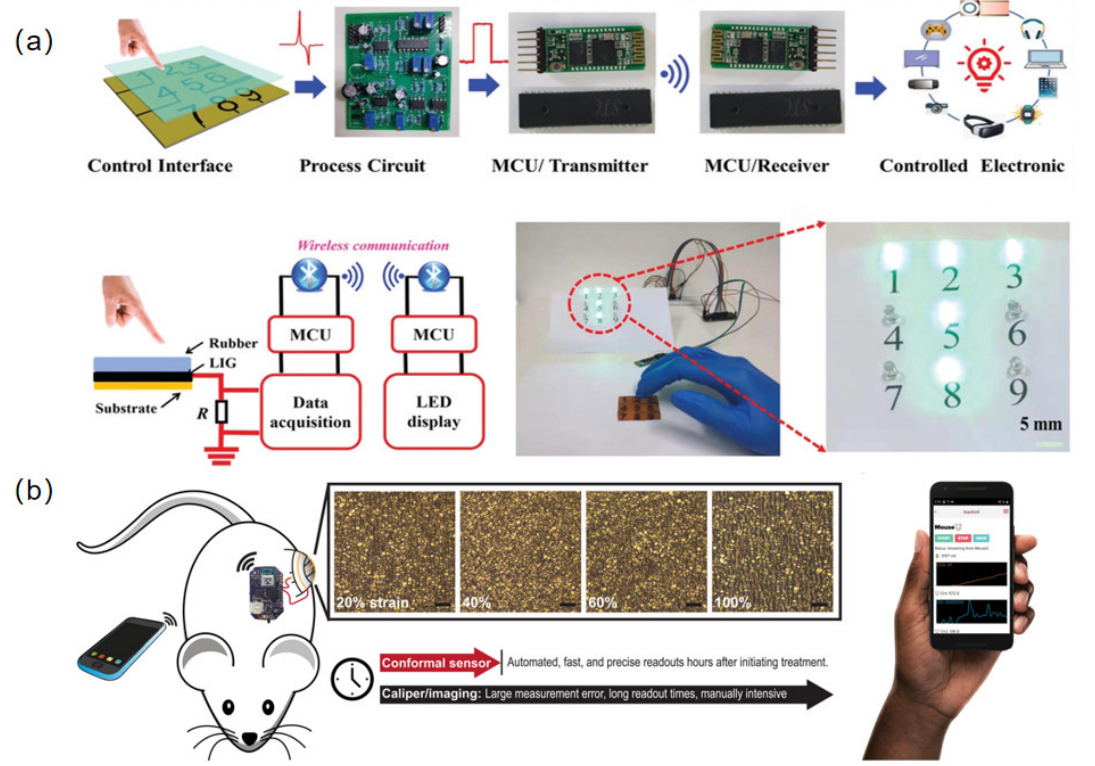
Figure 6. ( a ) Schematic illustration of a wireless control system for real-time motion tracking (reproduced with permission from [125]); ( b ) illustration of a strain sensor and its deployment in a rat model for monitoring the regression of tumors (reproduced with permission from [131]).